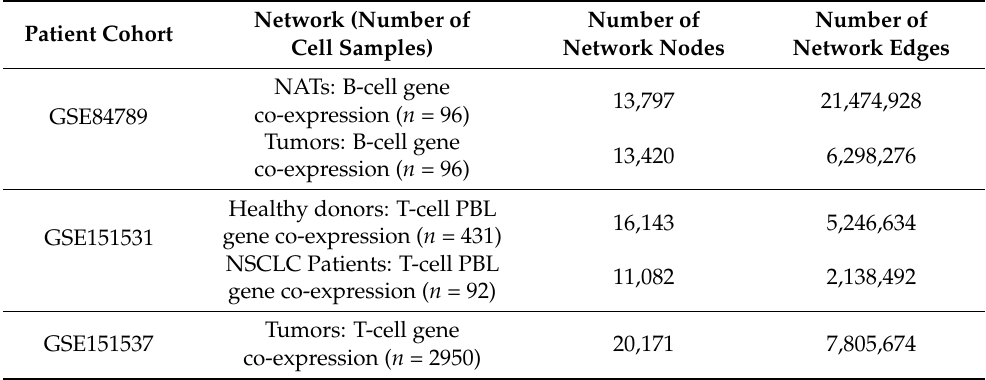
Number of Number of Network Nodes Network Edges 13,797 21,474,928 13,420 6,298,276 16,143 5,246,634 11,082 2,138,492 20,171